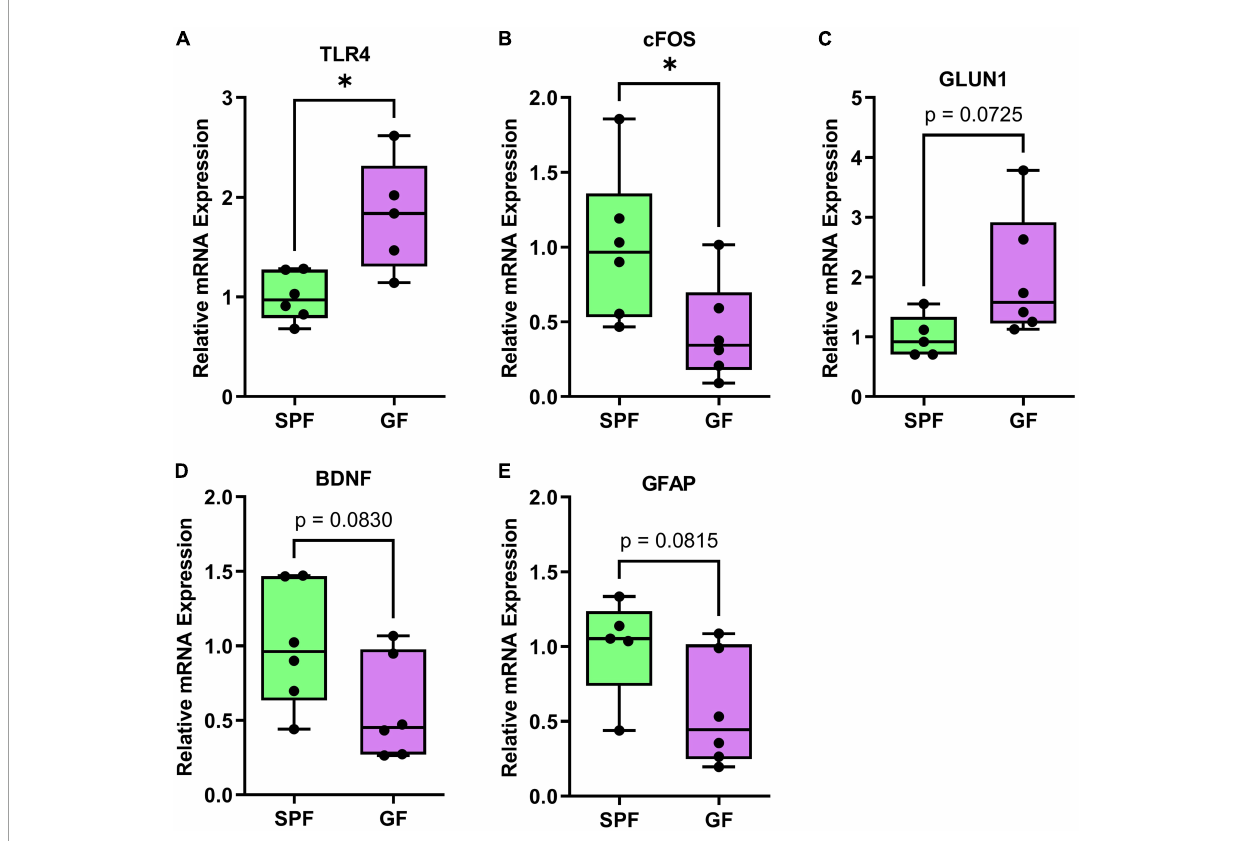
FIGURE6 Significant or trending genes from brain qPCR analysis in GF ( n = 6) and SPF ( n = 6) mice. ∗ p < 0.05, trending p < 0.1. Boxplots represent the interquartile range (IQR) and whisker display minimum/maximum values. (A) TLR4 had significantly higher expression in GF ( p = 0.0101 ∗ ). (B) cFOS had significantly lower expression ( p = 0.0435 ∗ ). (C) GLUN1 ( p = 0.0725) had higher expression, (D) BDNF ( p = 0.0830) and (E) GFAP ( p = 0.0815) had lower